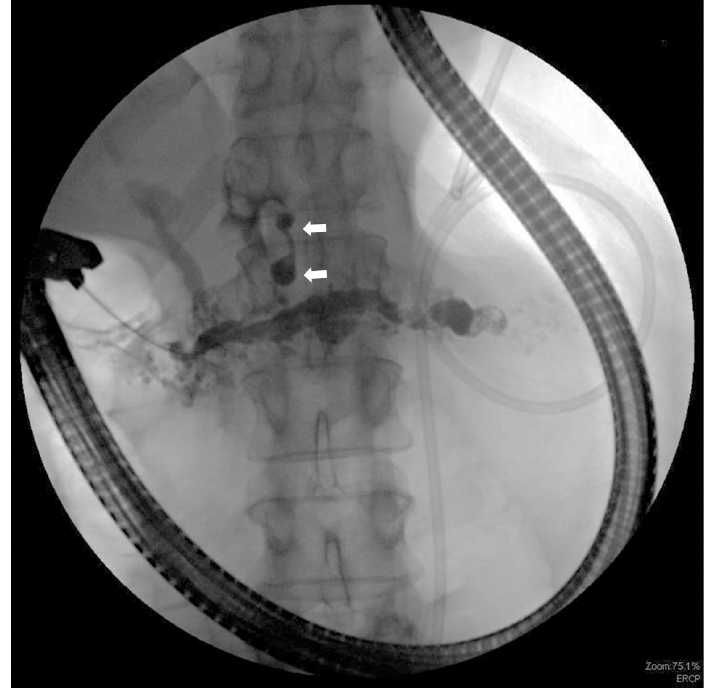
Figure 3. Calcifications consistent with chronic pancreatitis. Pancreatic fistula is shown by the arrow. Pancreatic fistula is shown by the